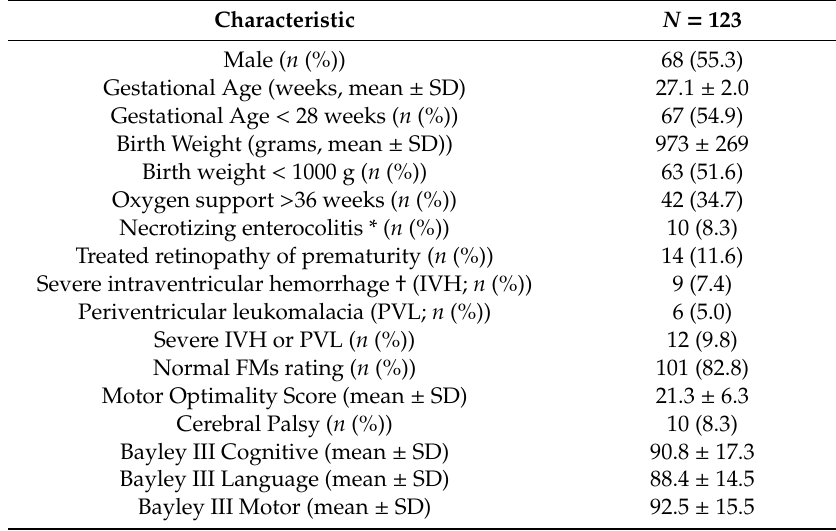
Table 1. Demographic and clinical characteristics of the study